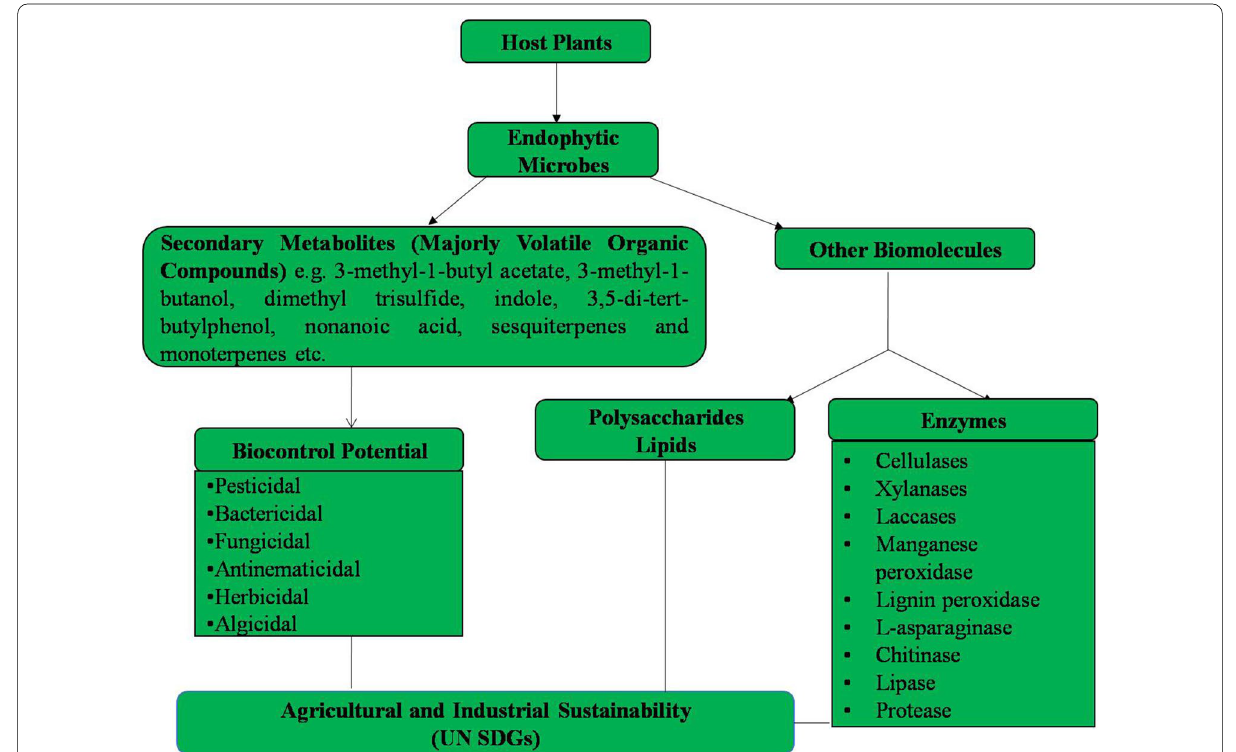
Fig. 1 Scheme of endophytes potentials in biocontrol and production of